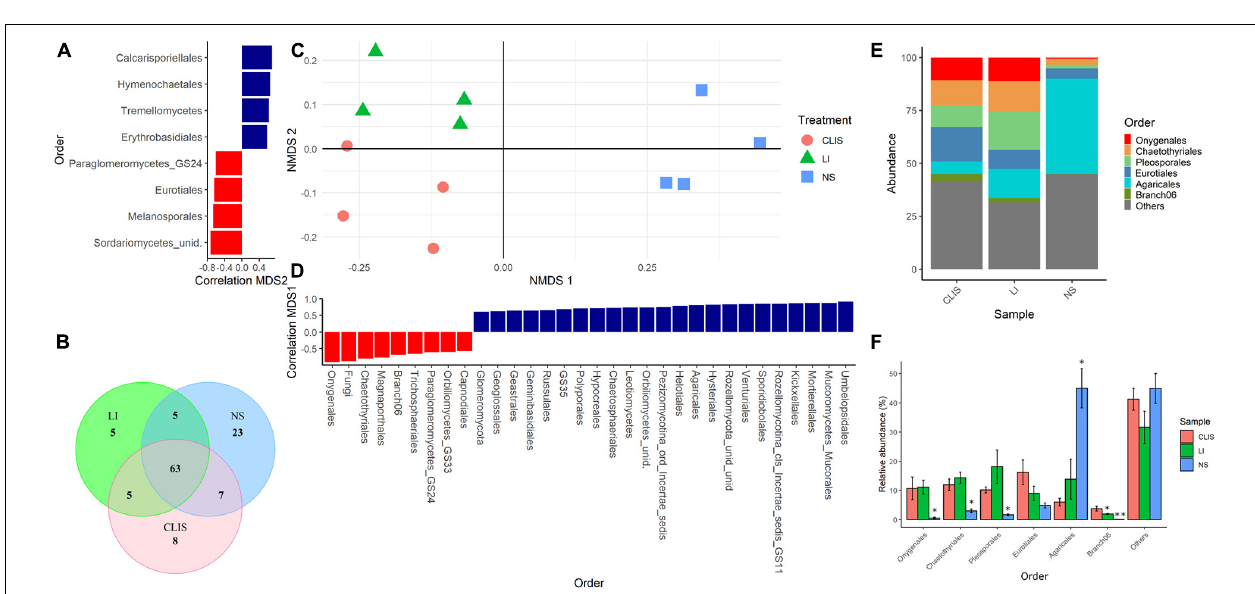
FIGURE 2 | Evaluation of the bacterial community (Family) in the native savanna (NS), low-input recovering (LI), and crop-livestock integrated system (CLIS) areas obtained by sequencing of 16S rRNA genes. (A) Family with significant correlation with the second component of NMDS. (B) Venn diagram obtained from Family data. (C) Individual coordinates from NMDS results. (D) Family with significant correlation with the first component of NMDS. (E) Relative abundance of bacterial families in each area. (F) Percentage of relative abundance of bacterial families in each area. Asterisks represent significance according to the Scott-Knott method p < 0.05.